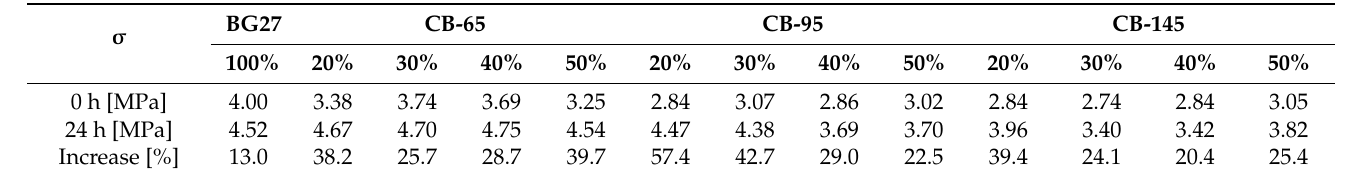
Table 4. Results of 3 point bending strength of hybrid sand compounds and the reference sample of pure silica sand.